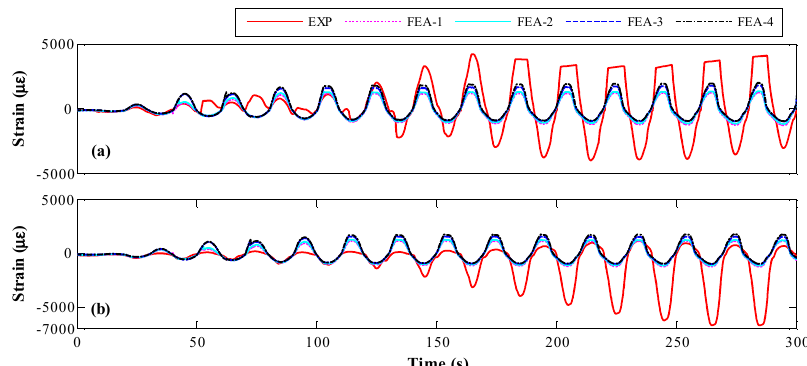
Figure 10. Strain time-history for different finite element model at different position along lateral loading direction: ( a ) − 149 mm; and ( b ) 149 mm.